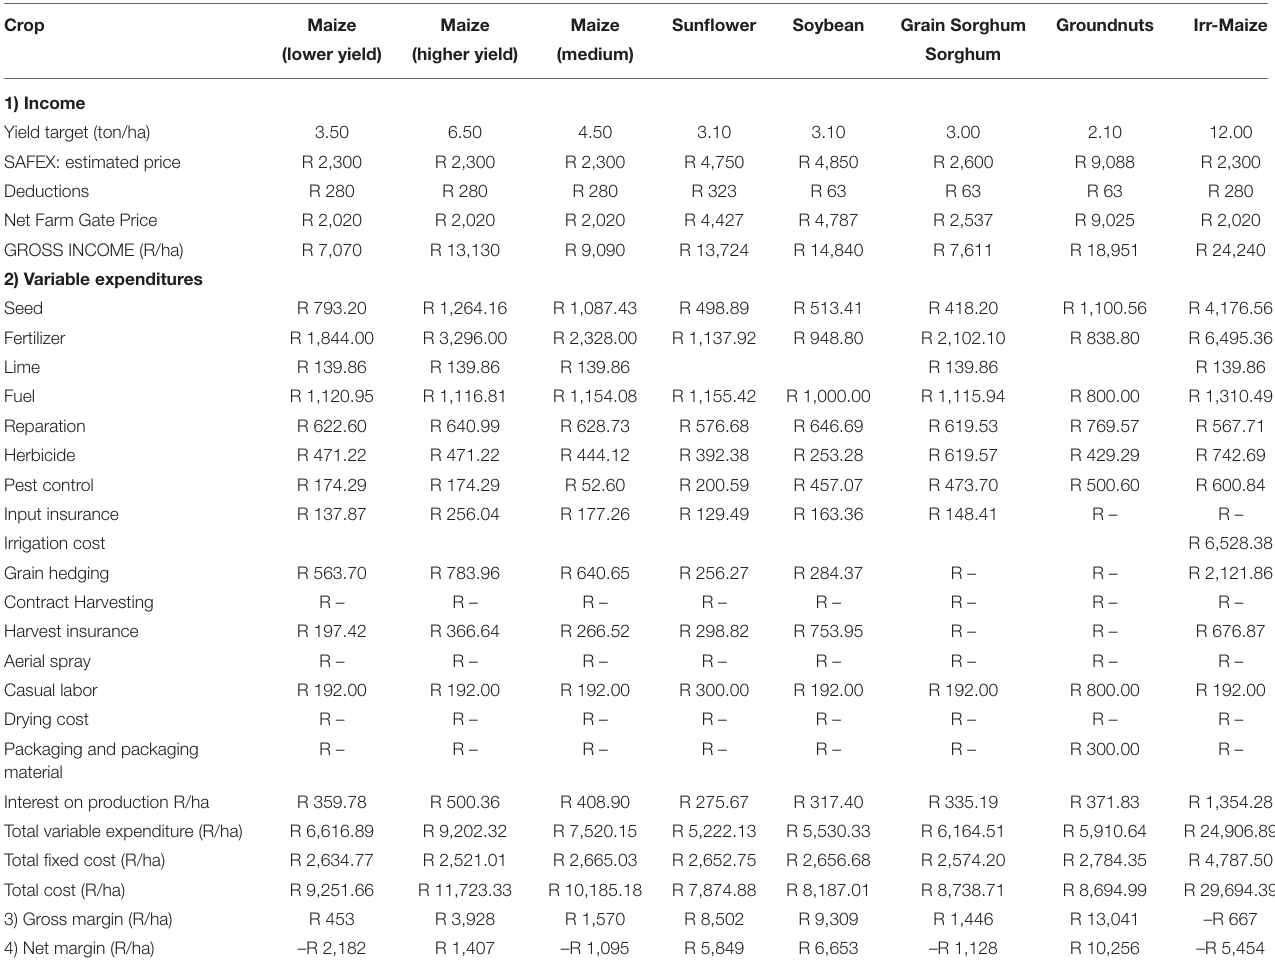
TABLE 3 | Cost analysis for selected summer crop production in the Free State Province. Crop Maize Maize Maize Sunflower Soybean Grain Sorghum (higher yield) (medium)